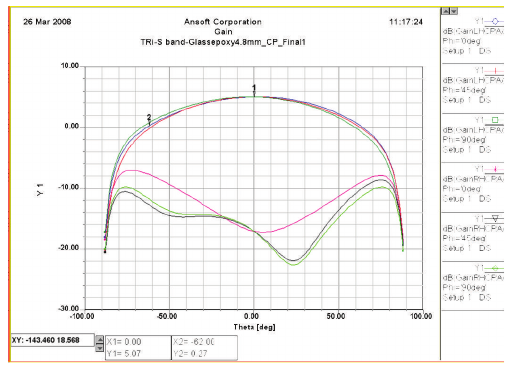
Figure 11: Gain radiation pattern.